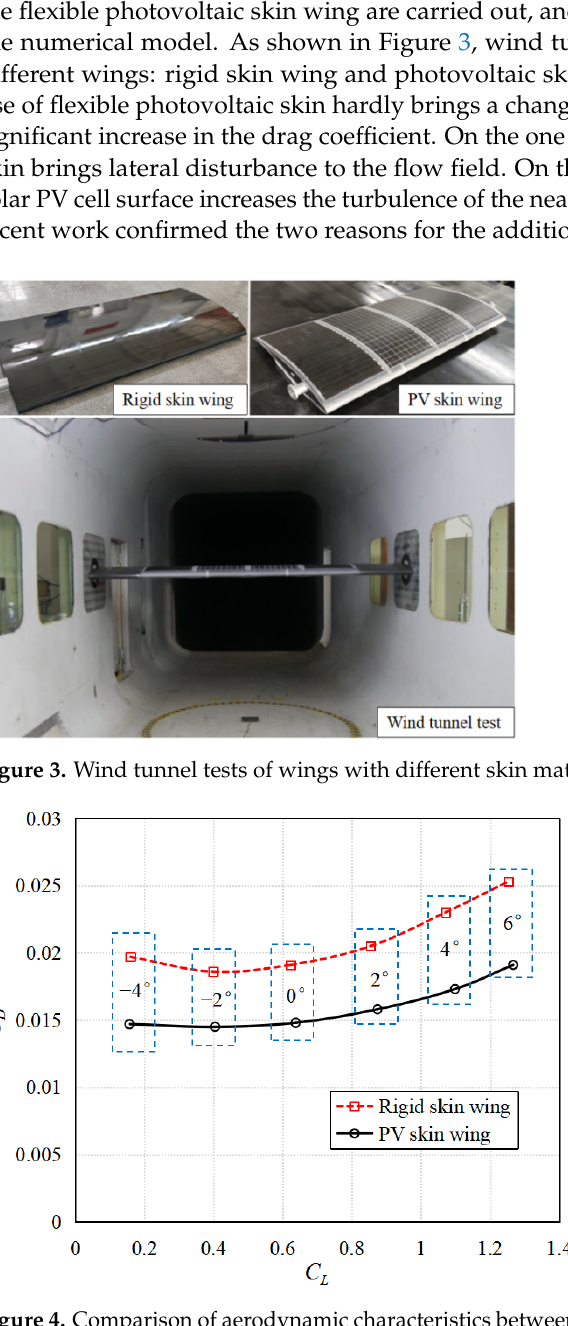
Figure 4. Comparison of aerodynamic characteristics between rigid skin and photovoltaic skin wings.